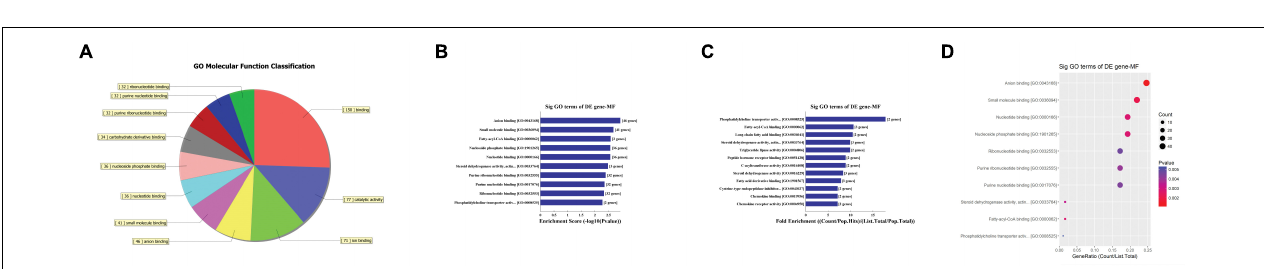
FIGURE 6 | The GO annotations for cellular component of target mRNAs regulated by the five candidate circRNAs. (A) The pie chart above shows the top 10 counts of the significant enrichment terms. (B) The bar plot shows the top 10 Enrichment Score values of the significant enrichment terms. (C) The bar plot shows the top 10-fold enrichment values of the significant enrichment terms. (D) The dot plot shows the gene ratio values of the top 10 most significant enrichment terms. Gene ratio: GOID’s gene ratio value, which equals (Count/List.Total).